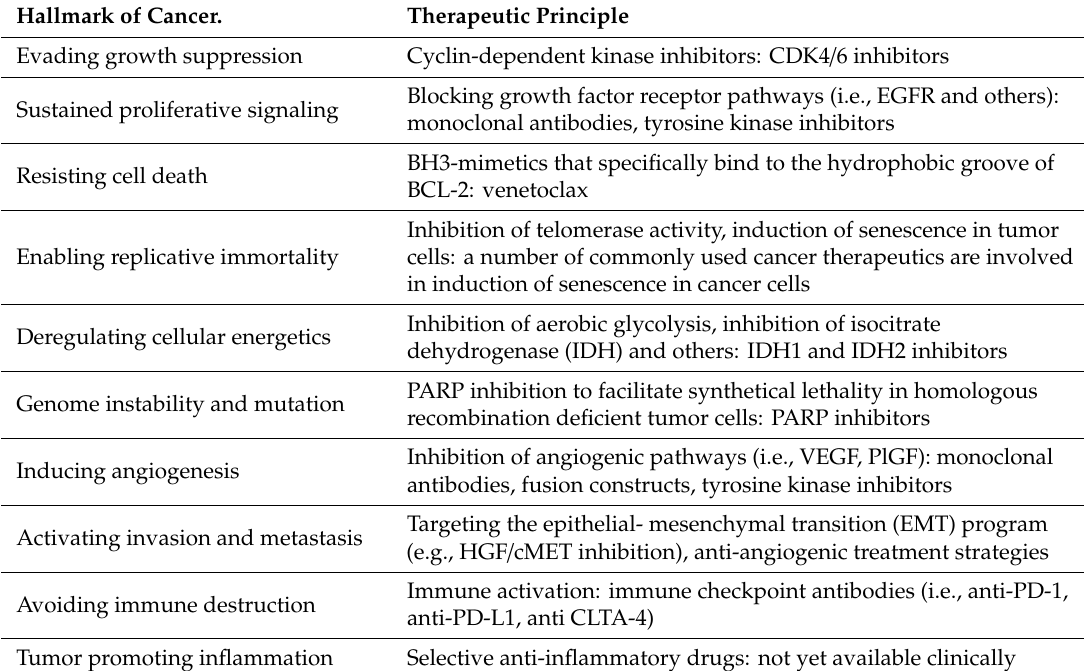
Table 1. Hallmarks of cancer and key examples of clinically available treatment strategies. Hallmark of